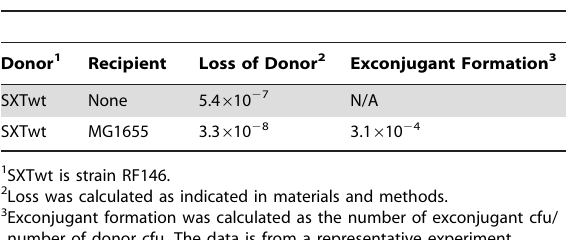
Table 2. Conjugation does not increase SXT